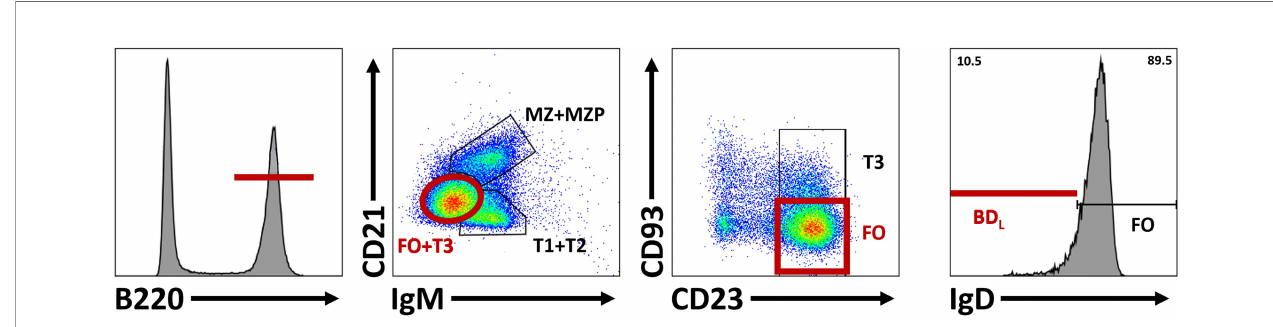
FIGURE 4 | Differentiation of BD L from other splenic B cell subsets. To identify BD L , B220 + cells are selected and subsequent comparison of lgM and CD21 subdivides B cells into three groups based on maturity: marginal zone (MZ) and marginal zone precursors (MZP), transitional 1 (TI) and T2 cell and T3 and follicular (FO) B cells. CD23 and CD93 are subsequently used to identify FO B cells. Within the FO B cell subset, BD L are selected for their low/negative expression of lgD.